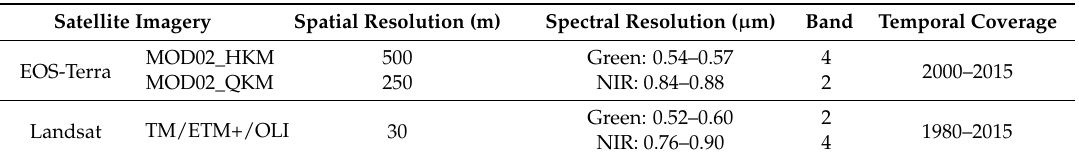
Table 1. Terra moderate resolution imaging spectroradiometer (MODIS) and Landsat instruments images used in this